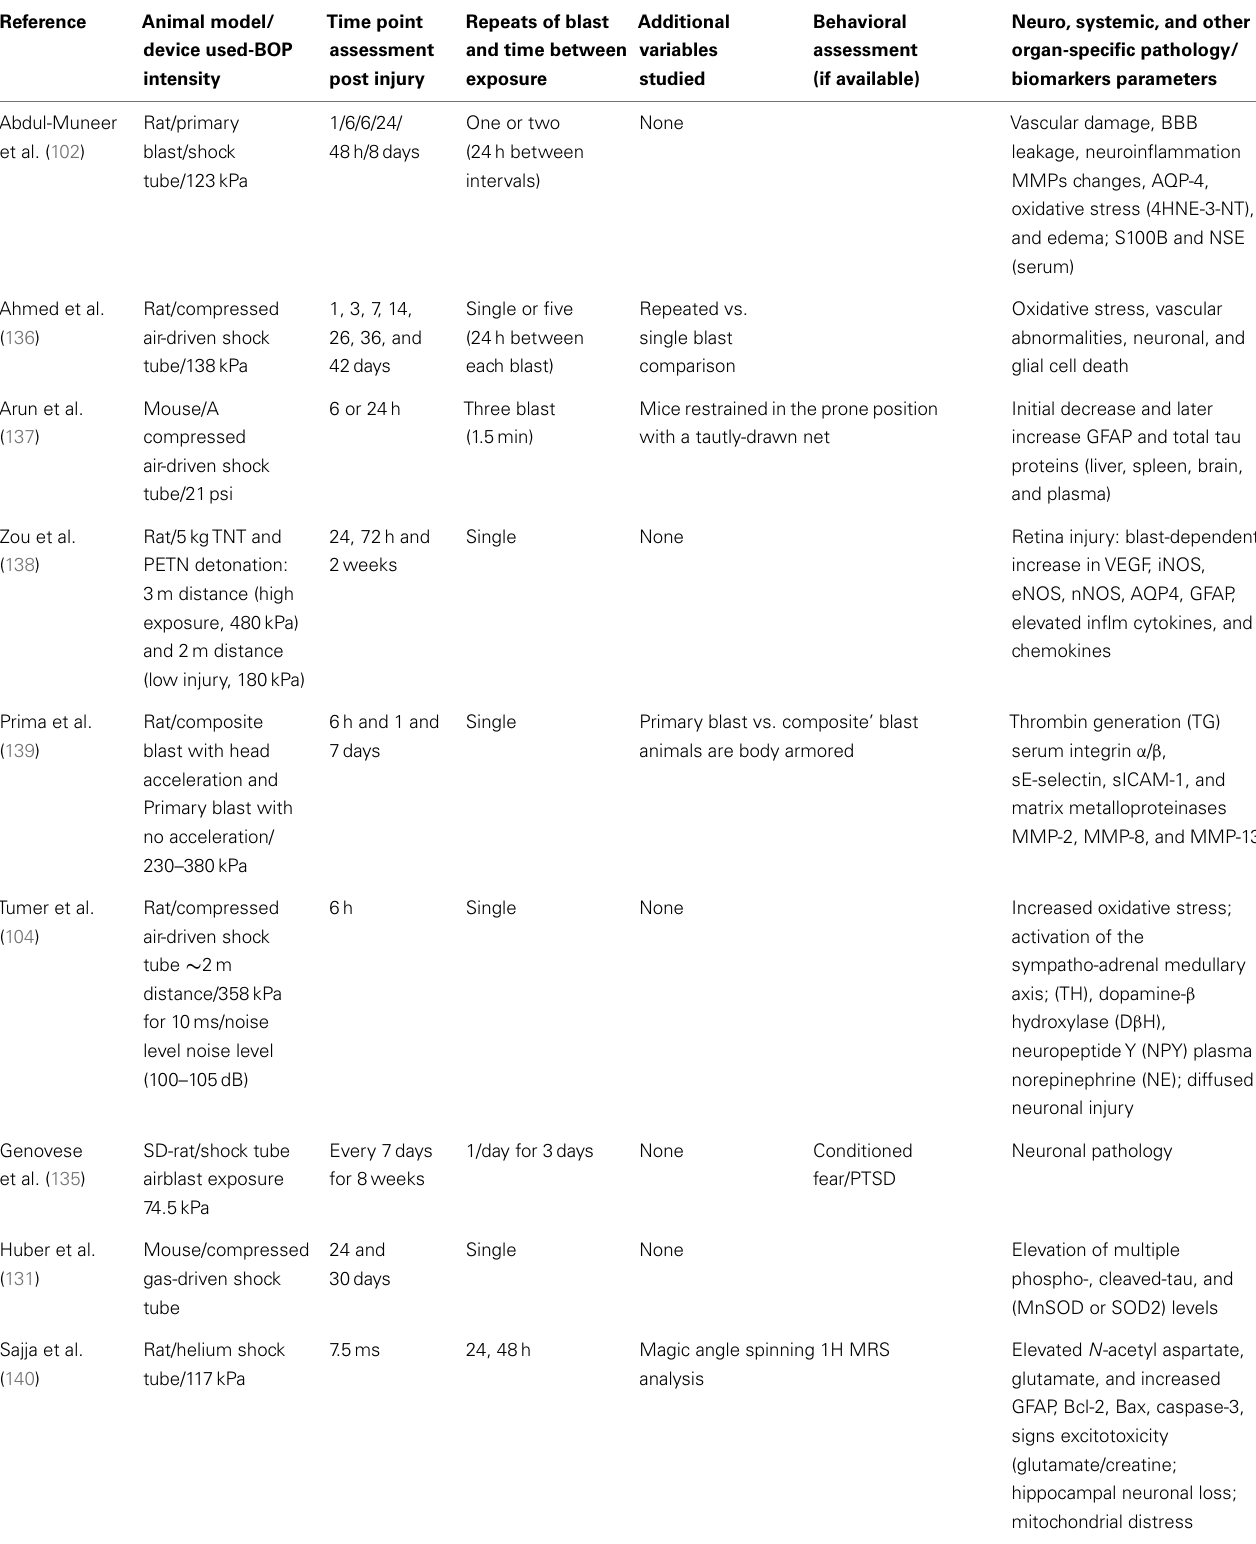
Table 1 | Recent major studies on experimental blast injury with different parameters assessed (behavioral, neuropathological, and biomarker changes)